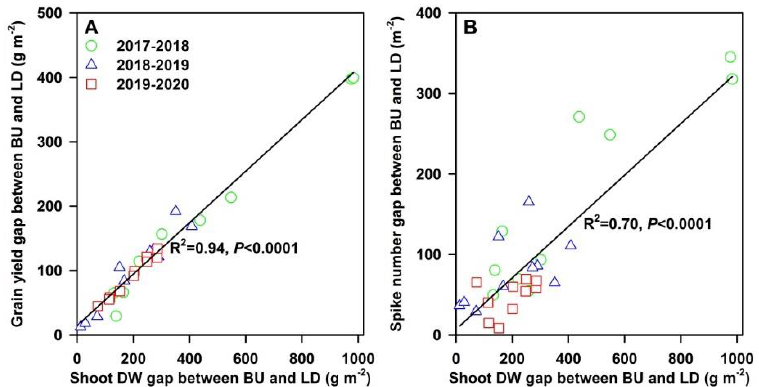
Figure 4. The relationship between the (A) grain yield (g m −2 ) gap and shoot dry weight (DW) gap (g m −2 ), (B) spike number (m −2 ) gap and shoot dry weight (DW) gap (g m −2 ), between the belt uniform (BU) and line and dense (LD) sowing patterns and five sowing density (SD; 75, 150, 225, 300, and 375 plants m −2 ) in the three consecutive growing seasons.